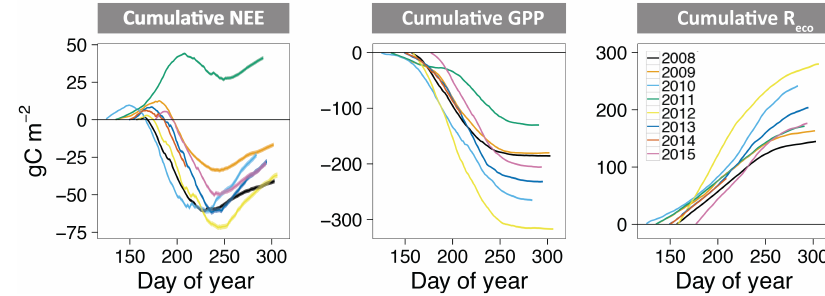
Figure 5. Cumulative NEE, GPP and R eco from 2008 through 2015 including the u ∗ filtering and random